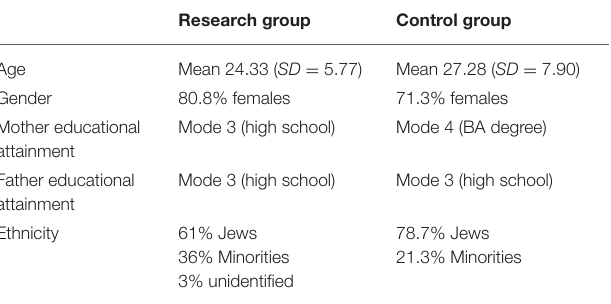
TABLE 1 | Student characteristics (research and control